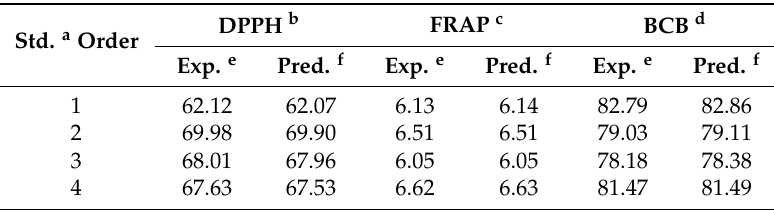
Table 2. The experimental and predicted values for the responses of the 1,1-Diphenyl-2-picrylhydrazyl (DPPH), ferric ion reducing antioxidant power (FRAP), and beta-carotene bleaching (BCB) assays under different extraction